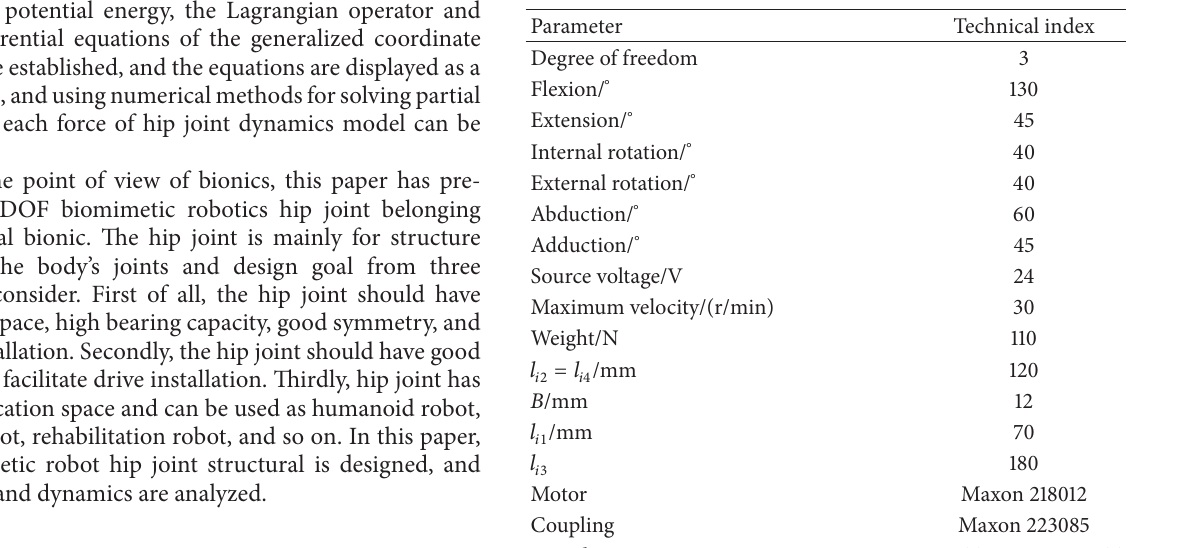
Table 1: The technical parameters of the biomimetic robotics hip